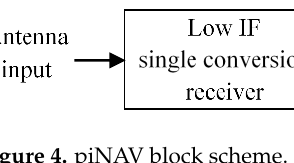
Figure 3. piNAV GPS receiver.